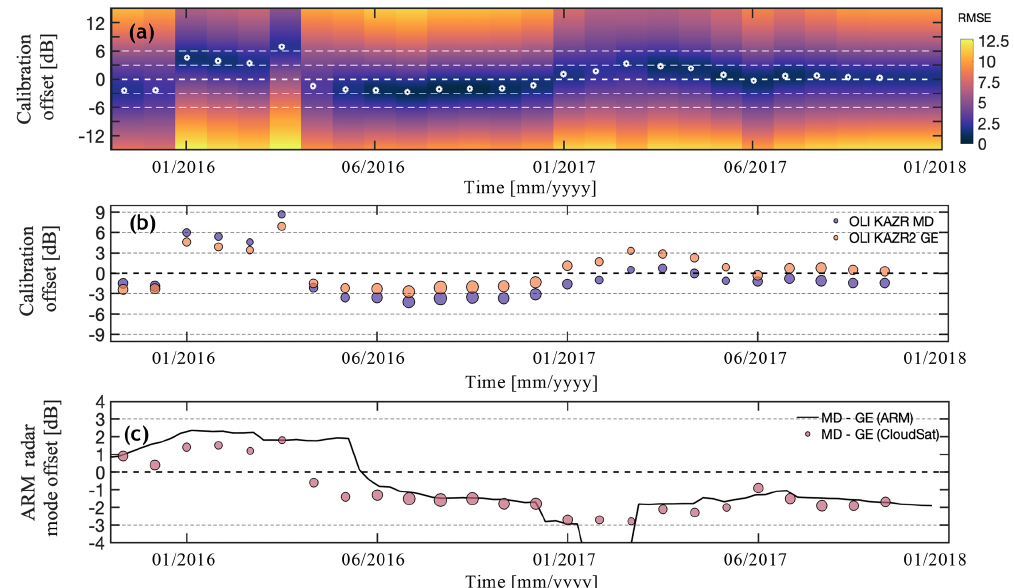
Figure 7. (a) The OLI KAZR2 MD mode calibration offset as reported by the CloudSat–ARM comparison (circles). The colors indicate the RMSE of the CloudSat–ARM comparison for different radar calibration offsets. (b) The AMF3 (Oliktok Point, Alaska) KAZR2 MD and GE mode calibration offset as reported by the CloudSat–ARM comparison. The size of the circles indicates the ratio of the sample size of the CloudSat columns for any given calibration offset estimate relative to the maximum sample size of CloudSat columns observed during the same period by the same mode. (c) The difference between the MD–GE modes as reported by the CloudSat–ARM comparison and as reported by the comparison of ARM radar mode to ARM radar mode.